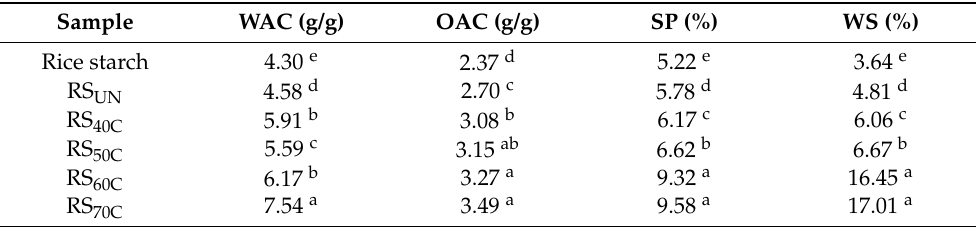
Table 4. Amylose content and technological and mechanical properties of rice starch and resistant starch (RS) isolated from untreated and sonicated rice bran. Sample WAC (g/g) OAC (g/g) SP (%) WS (%) Rice